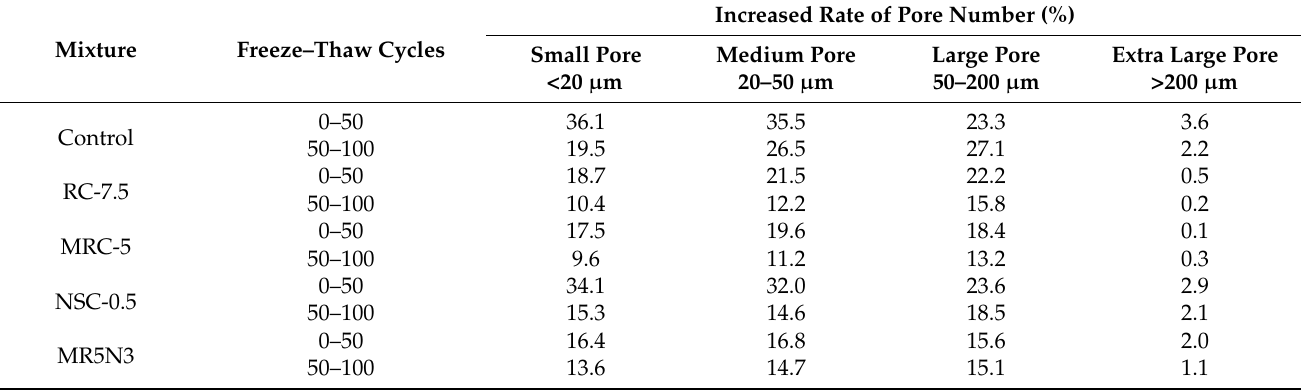
Table 6. Increased rate of pore numbers under freeze–thaw cycles.